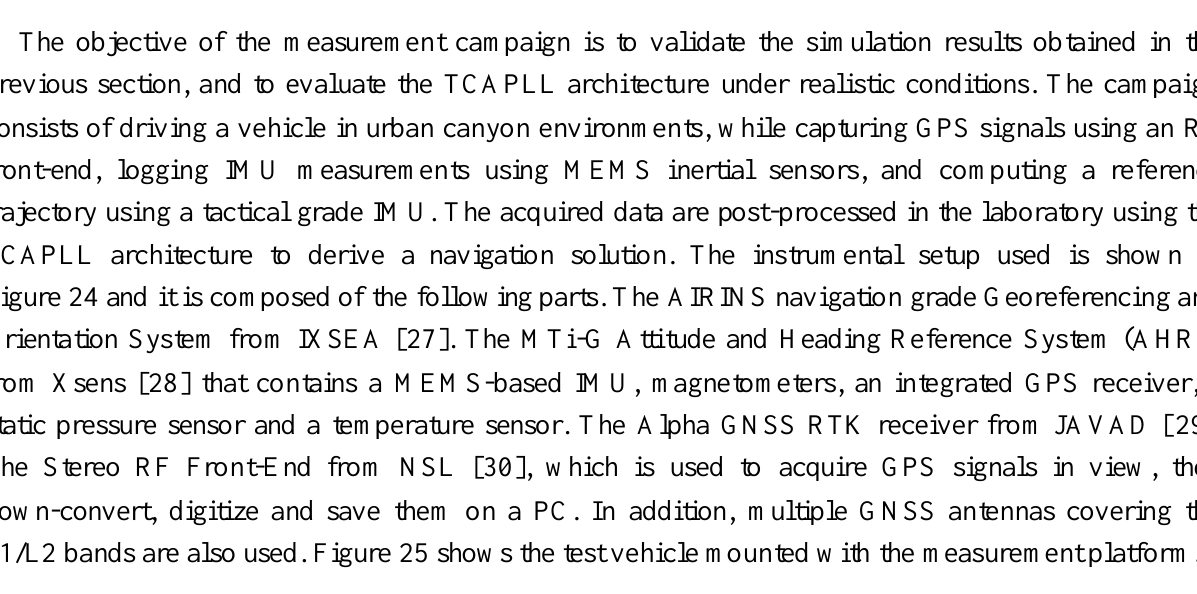
Figure 24. Setup used for the field vehicle test measurements.